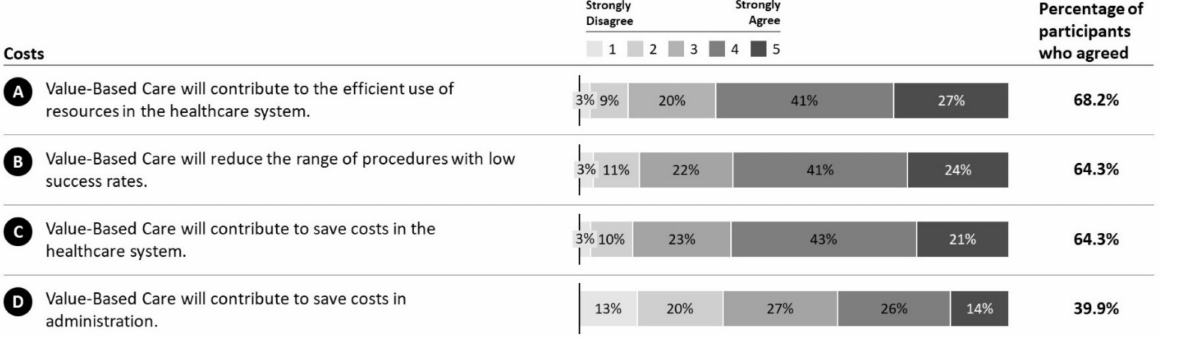
Figure 6. Category costs. Responses of participants along the VBC category costs. A : VBC contribu- tion to resource efficiency. B : VBC impact on procedure utilization. C : VBC contribution to healthcare cost savings. D : VBC contribution to administrative cost